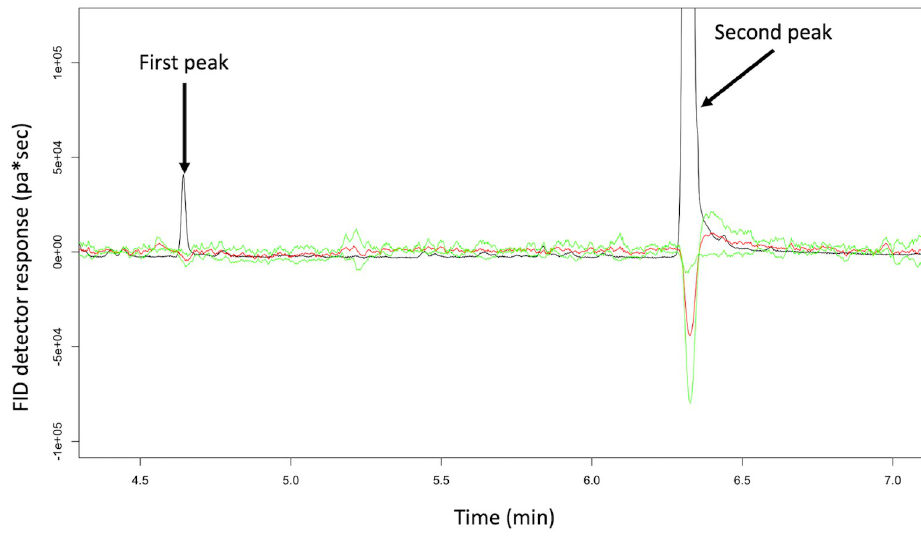
Fig 1. Processed female antennal responses to the first and second chromatographic peak from male effluvia. Black line: FID detector (pa), red line: mean antennal response ( μ V), green line: standard deviation (n = 6).